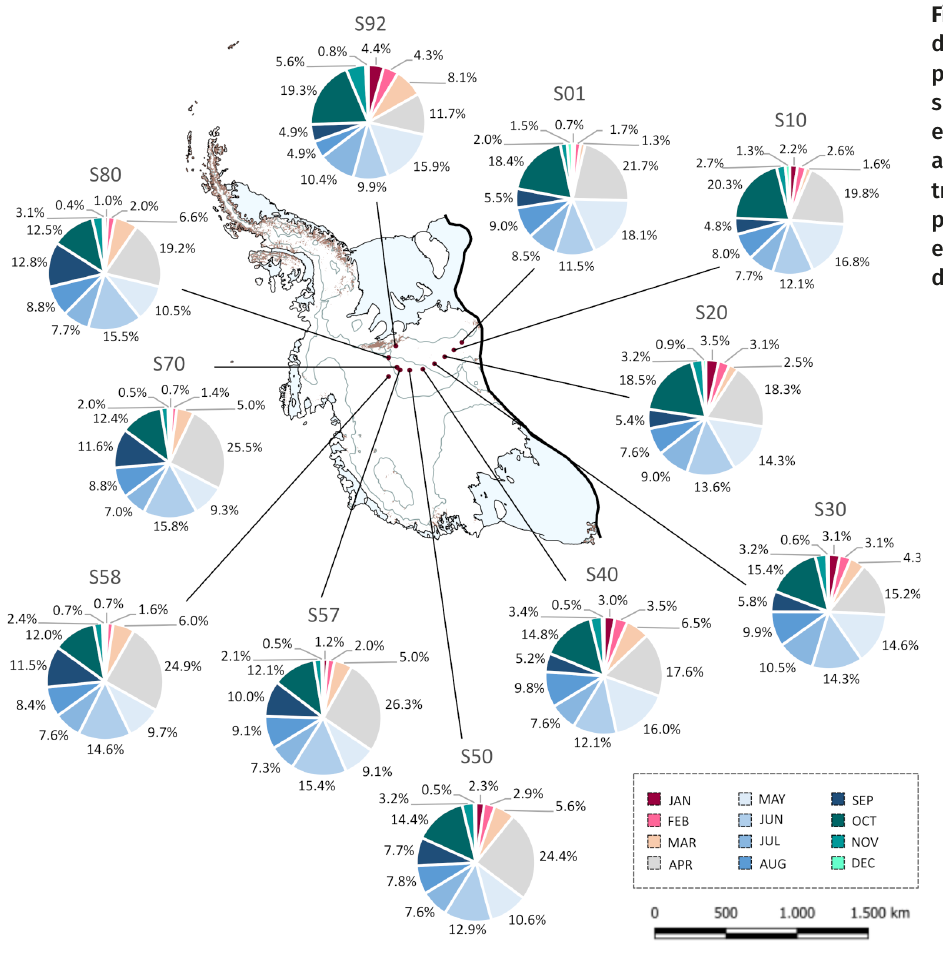
Figure 7. Annual distribution (in percentage) of 2014 snow precipitation for eleven sites sampled along the BR-WAIS traverse route. Total precipitation data were extracted from ERA 5